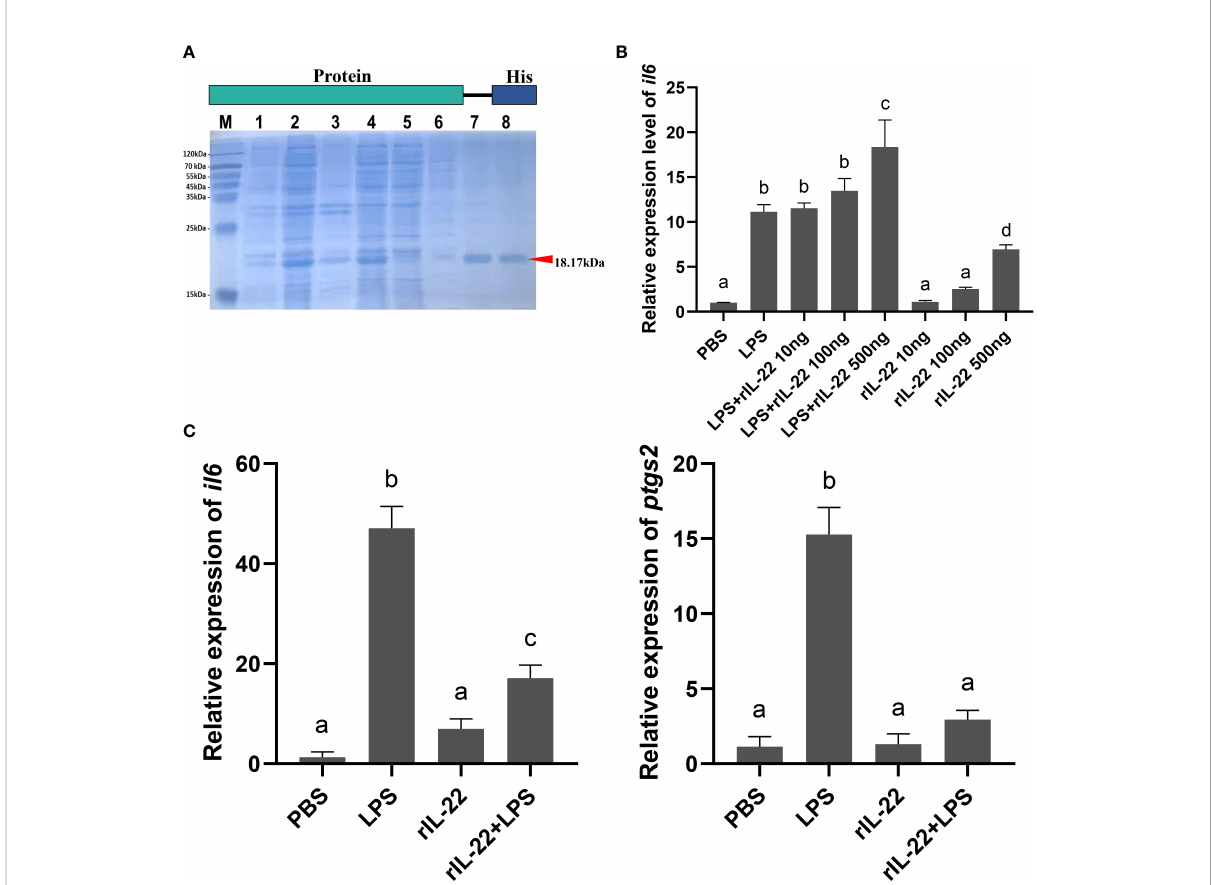
FIGURE 3 (A) SDS-PAGE analysis of puri fi ed rIL-22 (M: Marker; lane 1: Total protein in the thallus before induction; lane 2: Total protein in thallus after induction; lane 3: Protein in the precipitate after induction; lane 4: Protein in the supernatant after induction; lane 5, 6: The non-target proteins are washed down; lane 7, 8: Puri fi ed rIL-22 (18.17 kDa)). (B) Relative expression of il6 under PBS and different concentrate LPS and rIL-22 stimulation (n=3). (C) Relative expression of il6 and ptgs2 after PBS, LPS, rIL-22 and rIL-22 + LPS incubation, respectively (n=3). The X axis indicates different treatments. The Y axis indicates the relative expression normalized to 18s rRNA. All data are presented as the mean ± SD. Different letters indicate signi fi cant differences ( P <